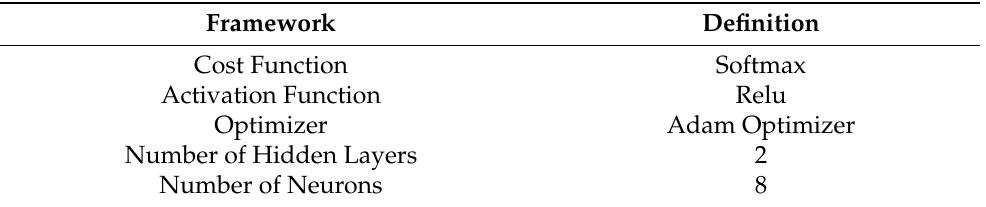
Table 1. Deep neural network (DNN) configuration